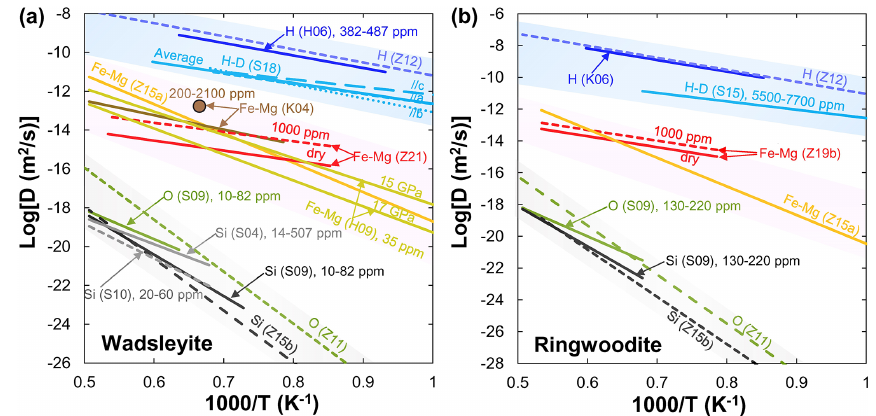
Figure 2. Arrhenius plot summarizing experimental results for various elements’ (H, Fe–Mg, O, Si) diffusion in wadsleyite (a) and ring- woodite (b) . Data sources: H06 (Hae et al., 2006); Z12 (Zhang, 2012); S18 (Sun et al., 2018); K06 (Kudo et al., 2006); K04 (Kubo et al., 2004); H09 (Holzapfel et al., 2009); S04 (Shimojuku et al., 2004); S09 (Shimojuku et al., 2009); S10 (Shimojuku et al., 2010); Z11 (Zhang et al., 2011); Z15a (Zhang and Shan, 2015a); Z15b (Zhang and Shan, 2015b); Z19b (B. H. Zhang et al., 2019b); Z21 (Zhang et al., 2021).